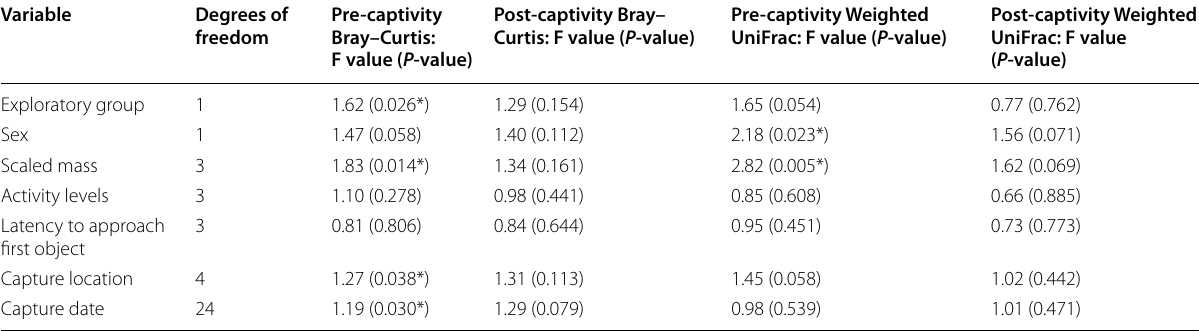
* indicates significance at 0.05 level